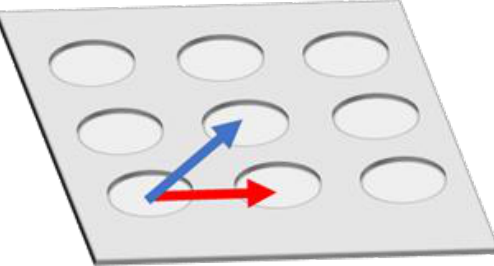
Figure 1. Schematic of 𝑘 𝑔 vectors in a hole-arrayed plasmonic chip. The red and blue arrows correspond to 𝑘 𝑔𝑥(1) and 𝑘 𝑔𝑥45(2) , respectively.